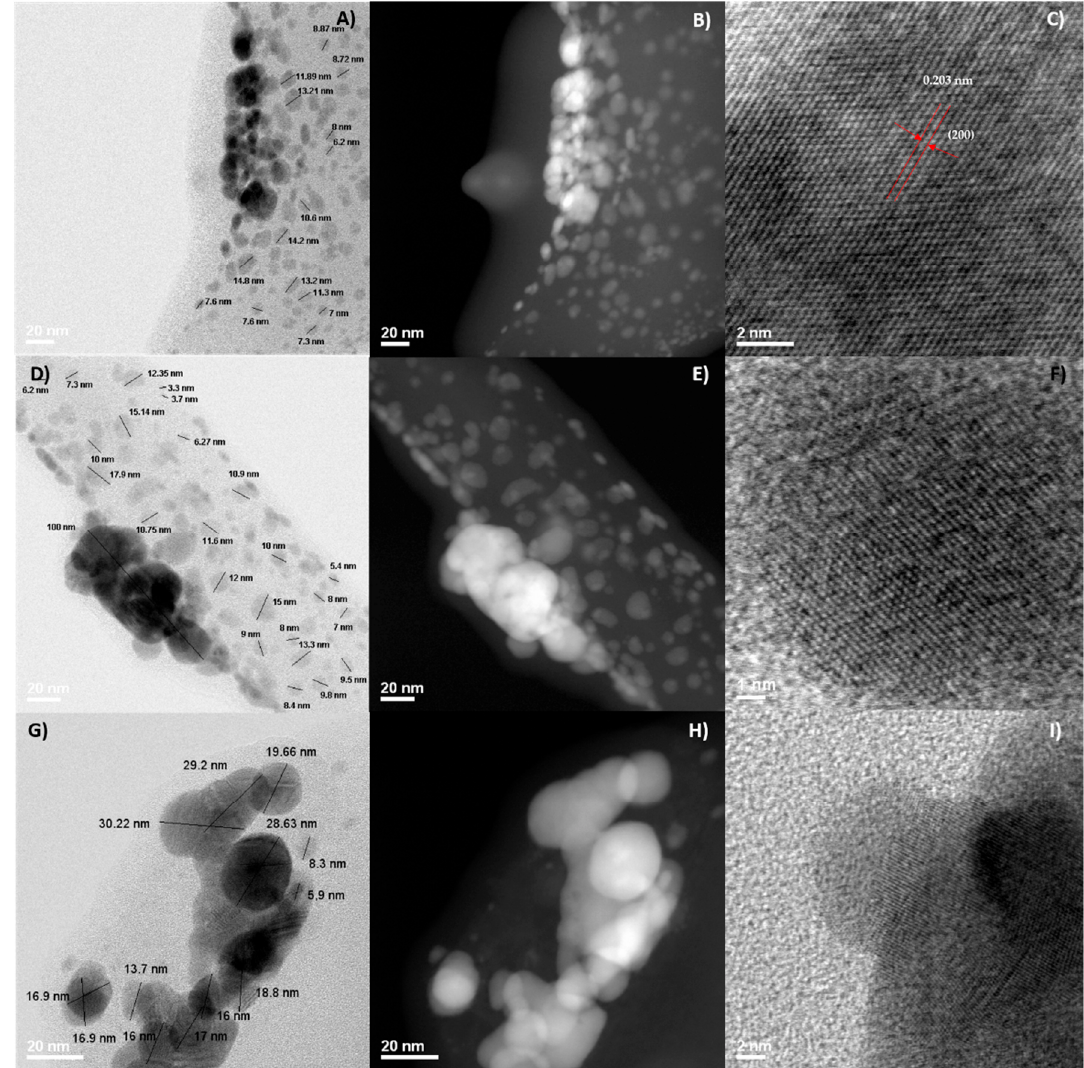
Figure 3. STEM micrographs of silver nanoparticles concentration 0.01 M, 15 min, 1:1 AgNO 3 :MG: ( A ) bright field; ( B ) dark field; and ( C ) measurement of interplanar distance for a particular nanoparticle. Silver nanoparticles concentration 0.2 M, 15 min, 1:1 AgNO 3 :MG: ( D ) bright field; ( E ) dark field; and ( F ) crystalline features. Silver nanoparticles concentration 0.5 M; 15 min, 1:1 AgNO 3 :MG: ( G ) bright field; ( H ) dark field; and ( I ) crystalline features.